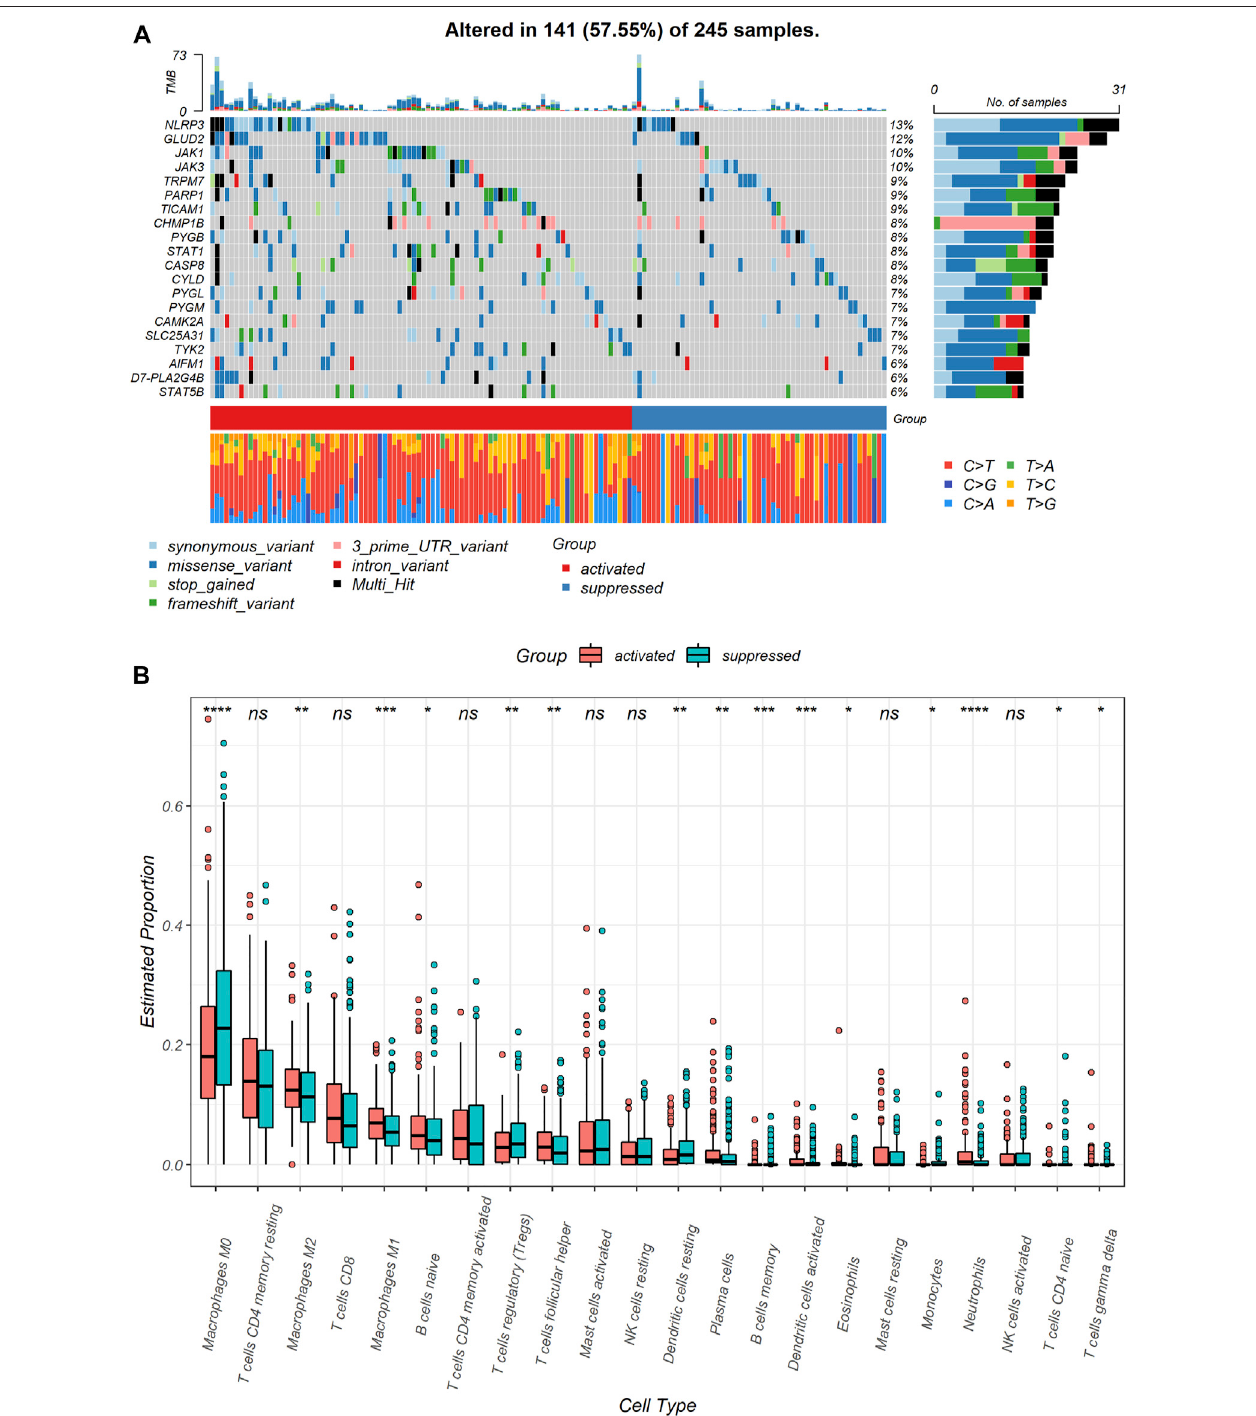
FIGURE 3 | Genomic and immune pro fi le alterations between the NRGs-activated and NRGs-suppressed subgroup. (A) Landscape of mutation pro fi les in colon cancersamples.Mutationinformationofeachgeneineachsampleisshowninthewaterfallplot.Toppanelshowsindividualtumormutationburden. (B) Thecomparison ofin fi ltrationlevelsof22immunecellsbetweentheNRGs-activatedandNRGs-suppressedgroups.*represents p < 0.05,**represents p < 0.01,***represents p < 0.01, **** represents p < 0.0001, ns represents no signi fi cant difference.